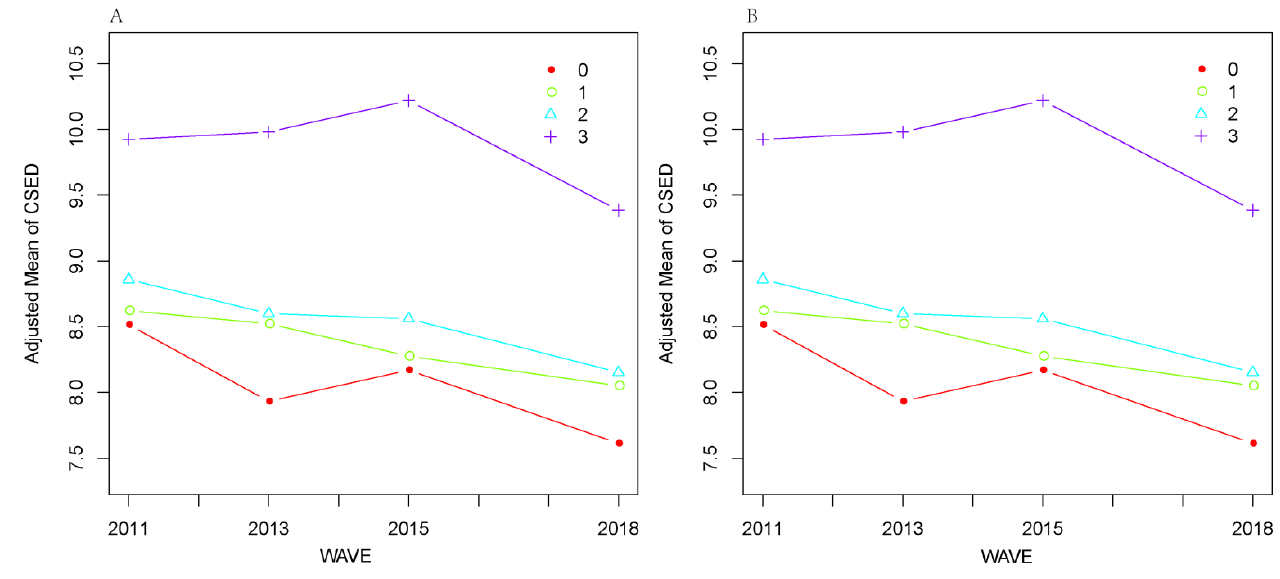
Figure 1. Smooth curve fitting for mean CES-D scores across different survey waves categorized by parental conflict and corporal punishment: ( A ) parental conflict; ( B ) corporal punishment. 0, Never; 1, Occasionally; 2, Sometimes; 3, Often.